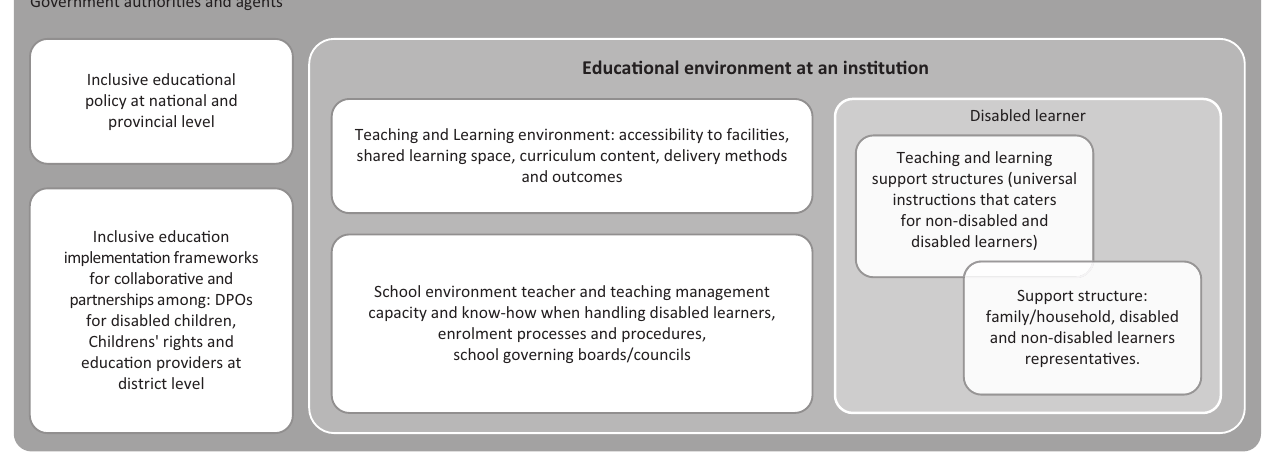
Based on Table 2 and Figure 1, the following 10 focal activities